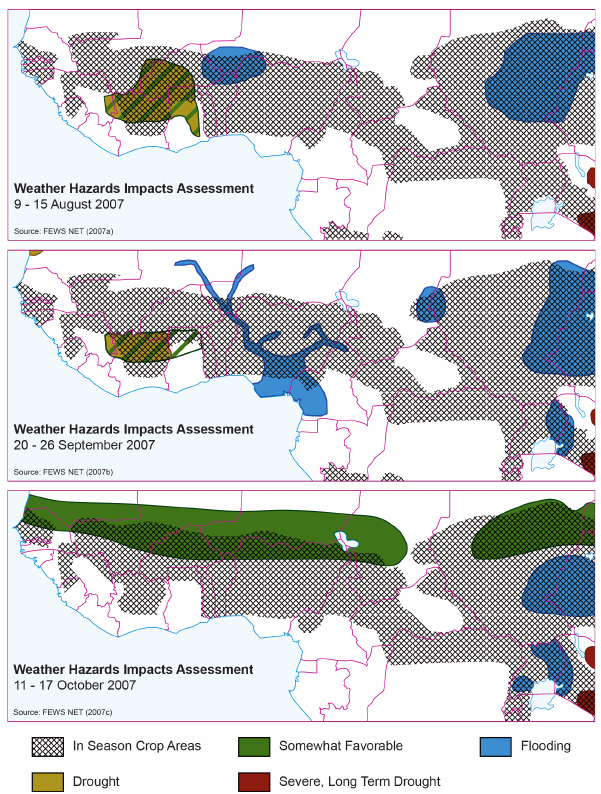
Fig. 5. FEWS NET – Weather Impacts Assessment for selected periods in